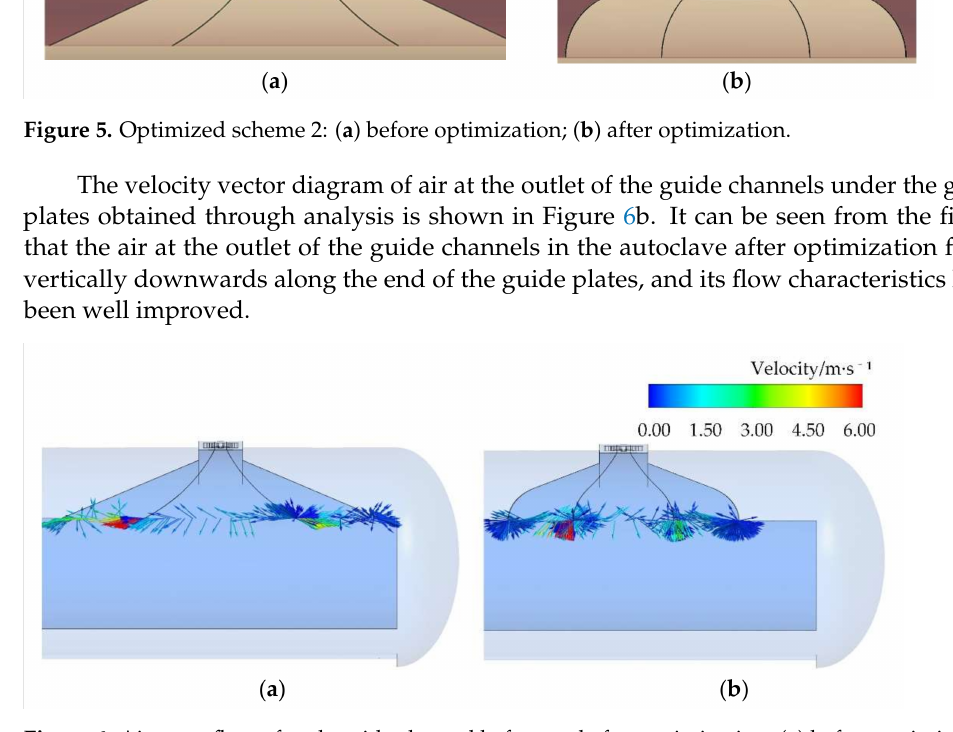
Figure 6. Air mass flow of each guide channel before and after optimization: ( a ) before optimization; ( b ) after optimization.